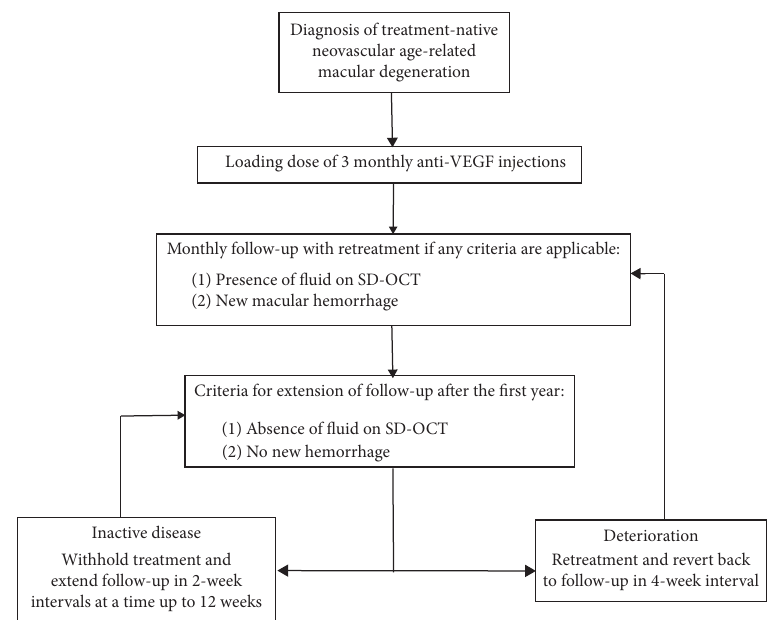
Figure 1: Personalized pro re nata treatment